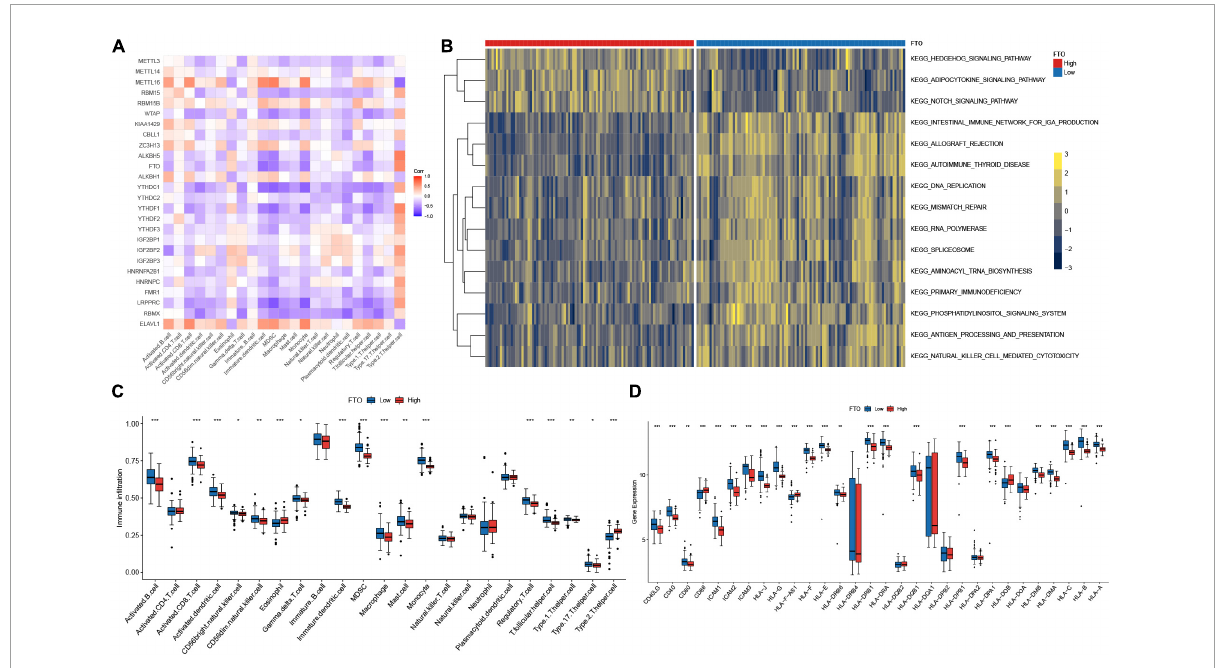
FIGURE6 FTO -mediated regulations of the immune microenvironment in juvenile idiopathic arthritis (JIA). (A) Correlations between m 6 A regulators and the immunocytes. (B) GSVA enrichment analysis shows the differences in the underlying biological processes between the JIA patients with high and low expression of FTO . (C) The discrepancies in the abundance of each infiltrating immunocyte between the JIA patients with high and low expression of FTO. (D) Patients with low-expressed FTO exhibited significantly higher expression of co-stimulatory molecules, adhesion molecules, and